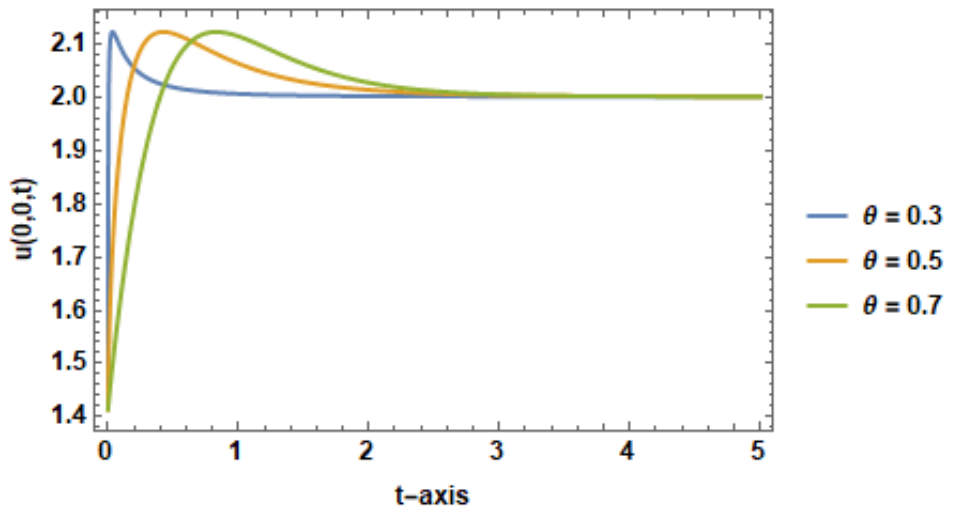
Figure 4. The 2D shape of the solution (34) for α = 2, β = 1, l = p = 1, λ = − 4, µ = 4, B = − 1, and ρ 2 = 1 .